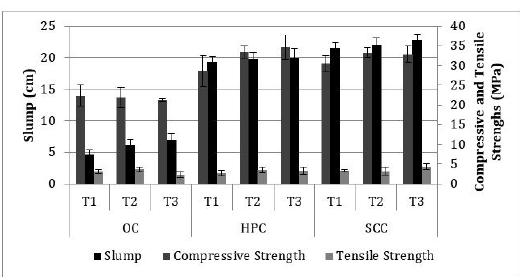
Figure 3. Reduction of aggregate in mass.